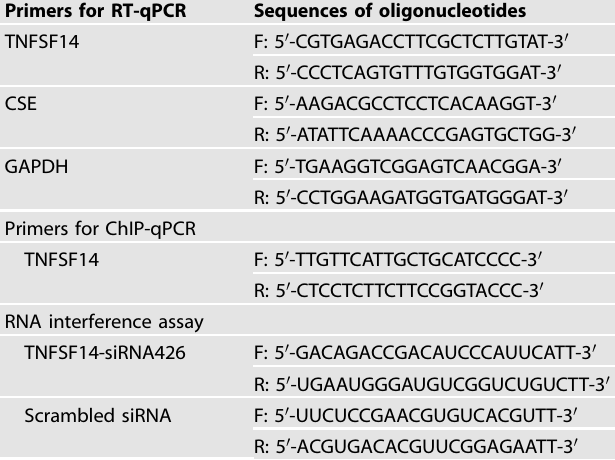
Table 1. Sequences of oligonucleotides used for RT-qPCR, ChIP-qPCR, and RNA interference assays.